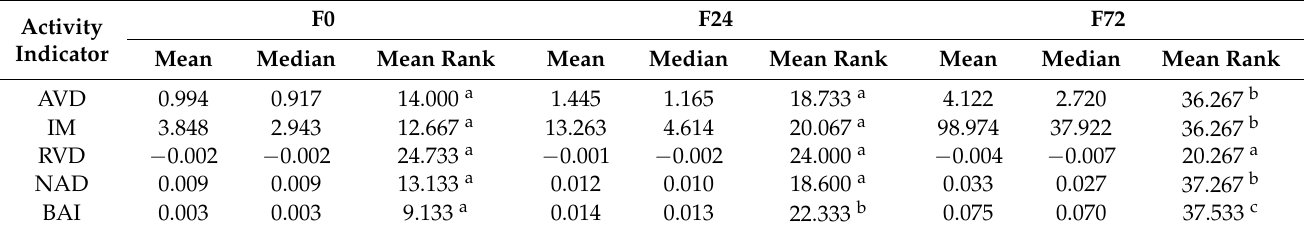
Table 1. Basic statistics calculated for THSP obtained from single column of ROI of 51 × 51 pixels with the global maximum at the central